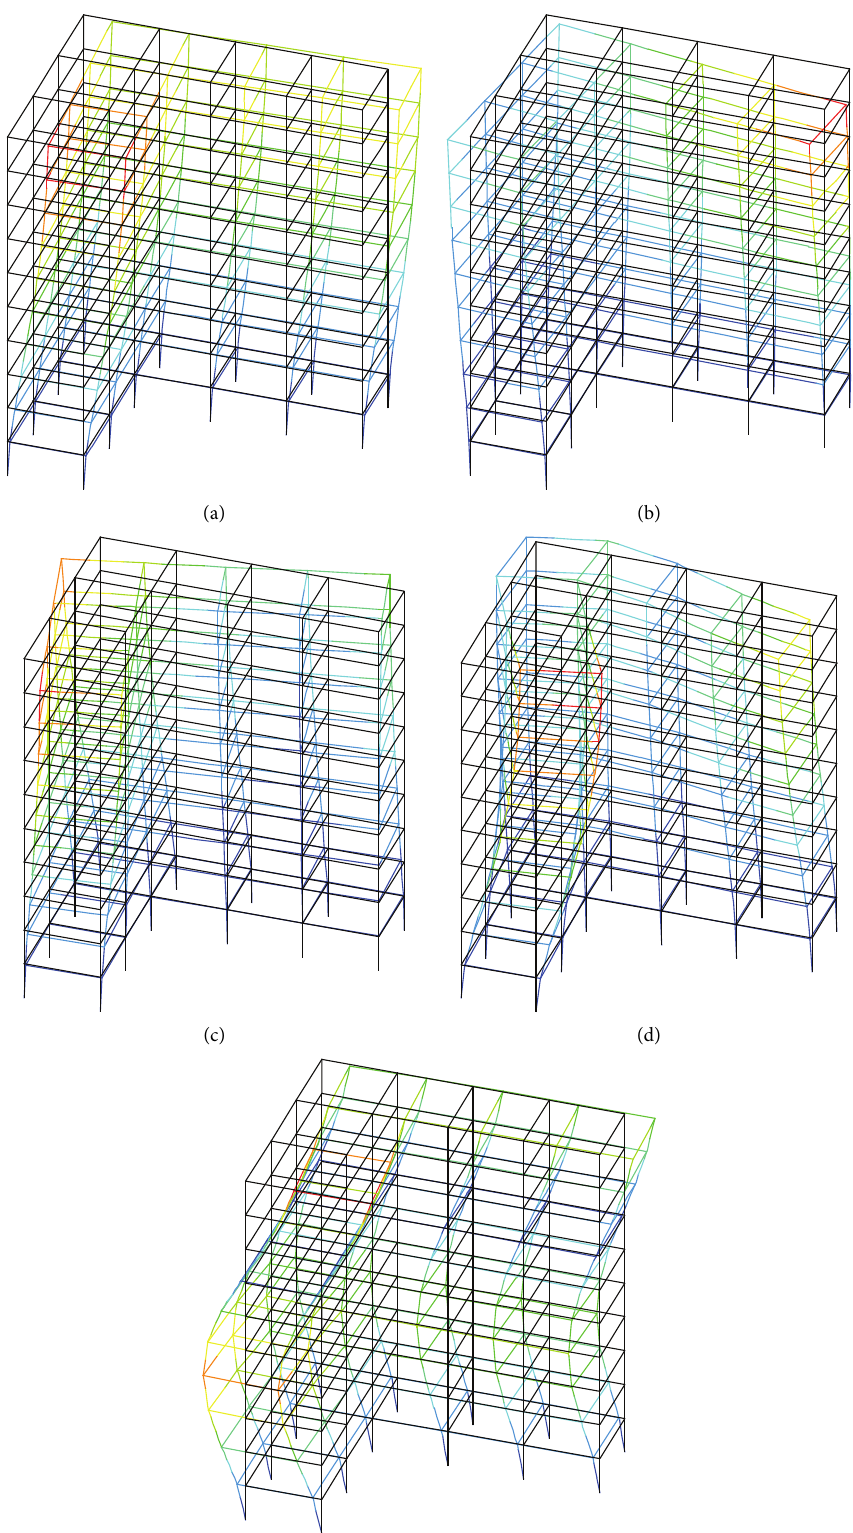
Figure 2: First 5 modes of L-shaped building model. (a) 1st mode (0.69 Hz). (b) 2nd mode (0.79 Hz). (c) 3rd mode (0.87 Hz). (d) 4th mode (1.78Hz). (e) 5th mode